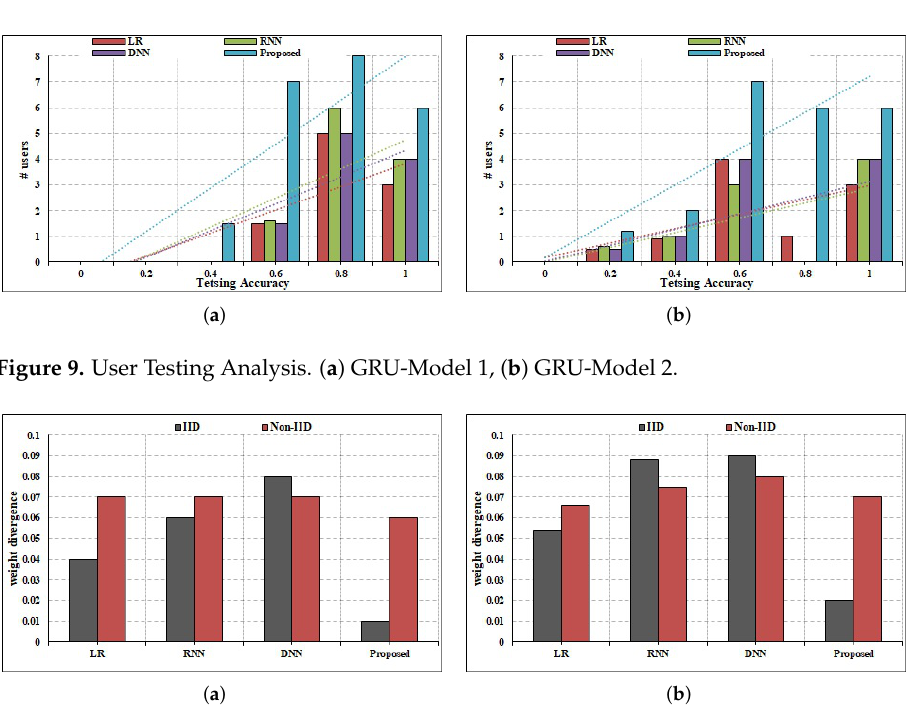
Figure 8. Memory Consumption Analysis. ( a ) GRU-Model 1, ( b ) GRU-Model 2.